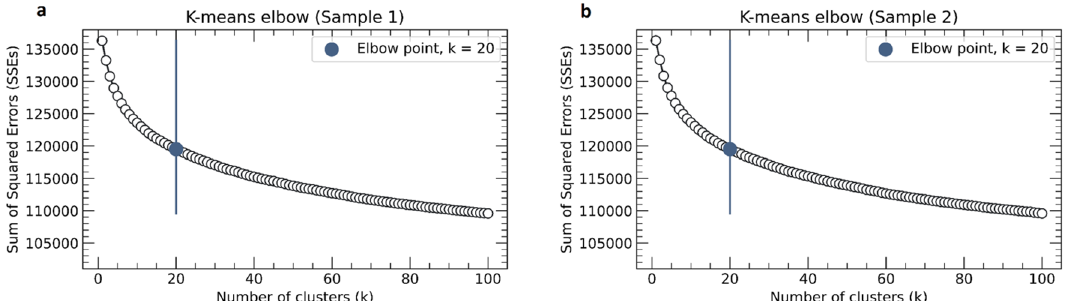
Figure 3. Optimizing the number of clusters (k) using the Elbow method. It is a heuristic technique used to determine the number of optimum clusters in a given sample. Here, the explained variation (SSE) has been plotted as a function of the number of clusters for both Sample 1 ( a ) and Sample 2 ( b ) obtained earlier. The blue vertical lines at k = 20 denote the elbows of the plotted lines, signifying 20 numbers of optimum clusters in both Sample 1 and 2, beyond which SSE starts to decrease in a somewhat linear fashion as seen in both left as well as right